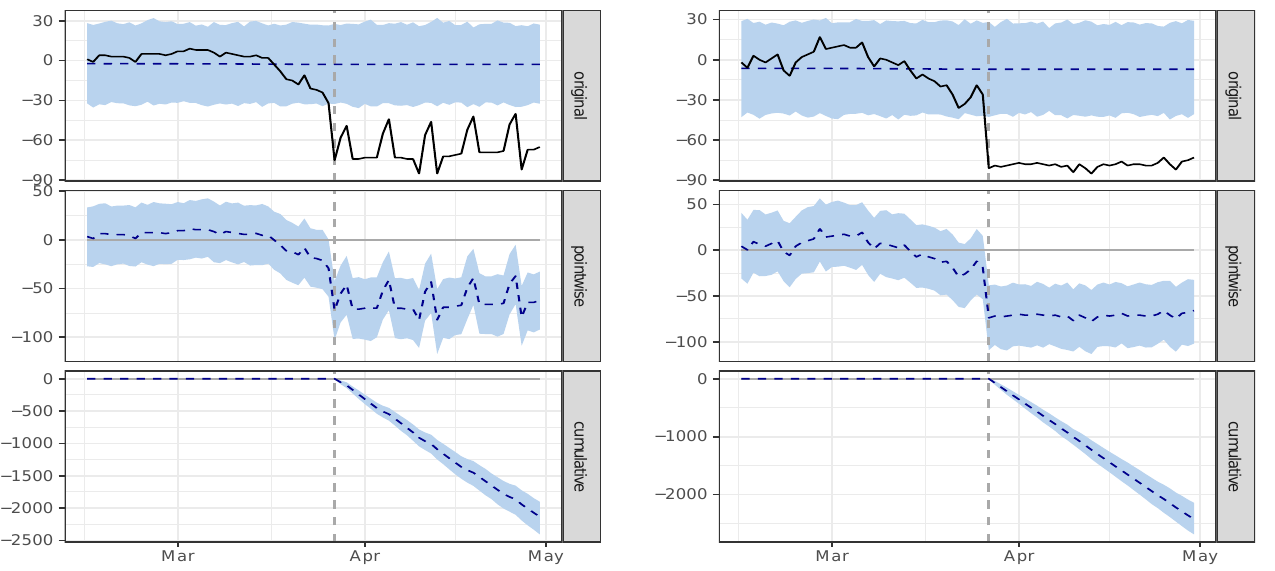
Figure 10. Left : Effect of the national full lockdown Level 5 on workplaces Right : Effect of the national full lockdown Level 5 on transit stations.